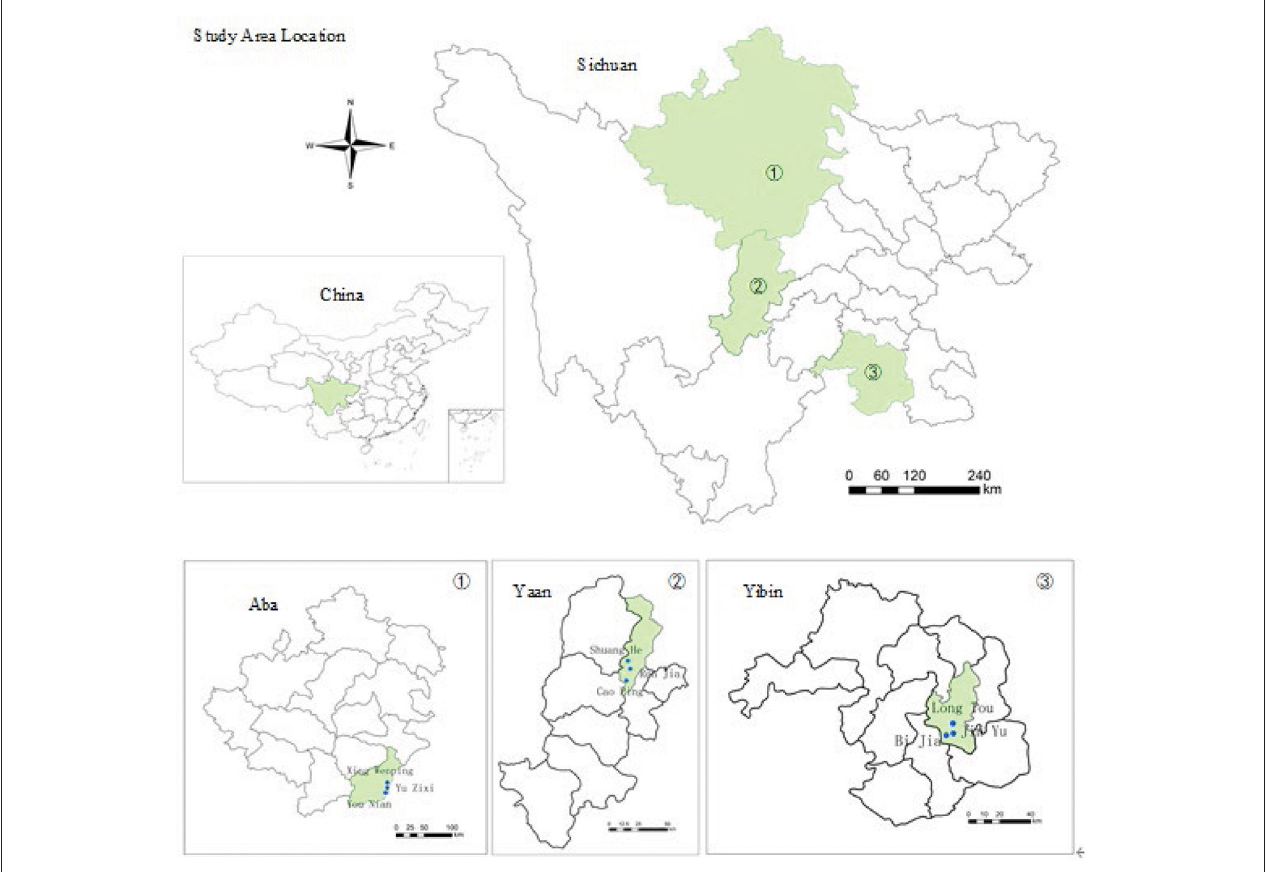
FIGURE 2 | Sample villages